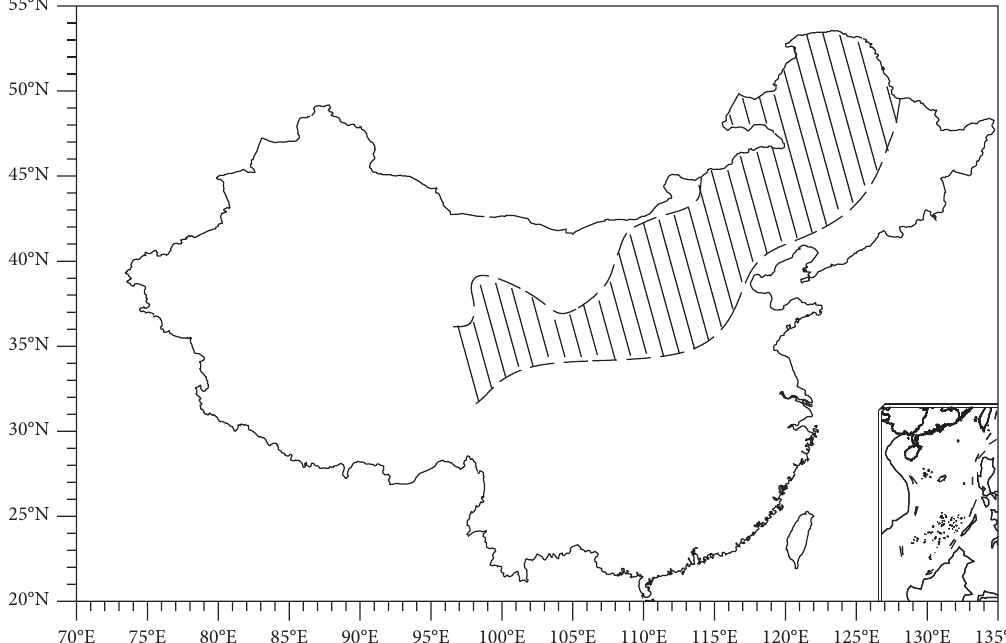
Figure 1: Distribution of the summer monsoon border zone in China (the area marked by the oblique line represents the summer monsoon transition